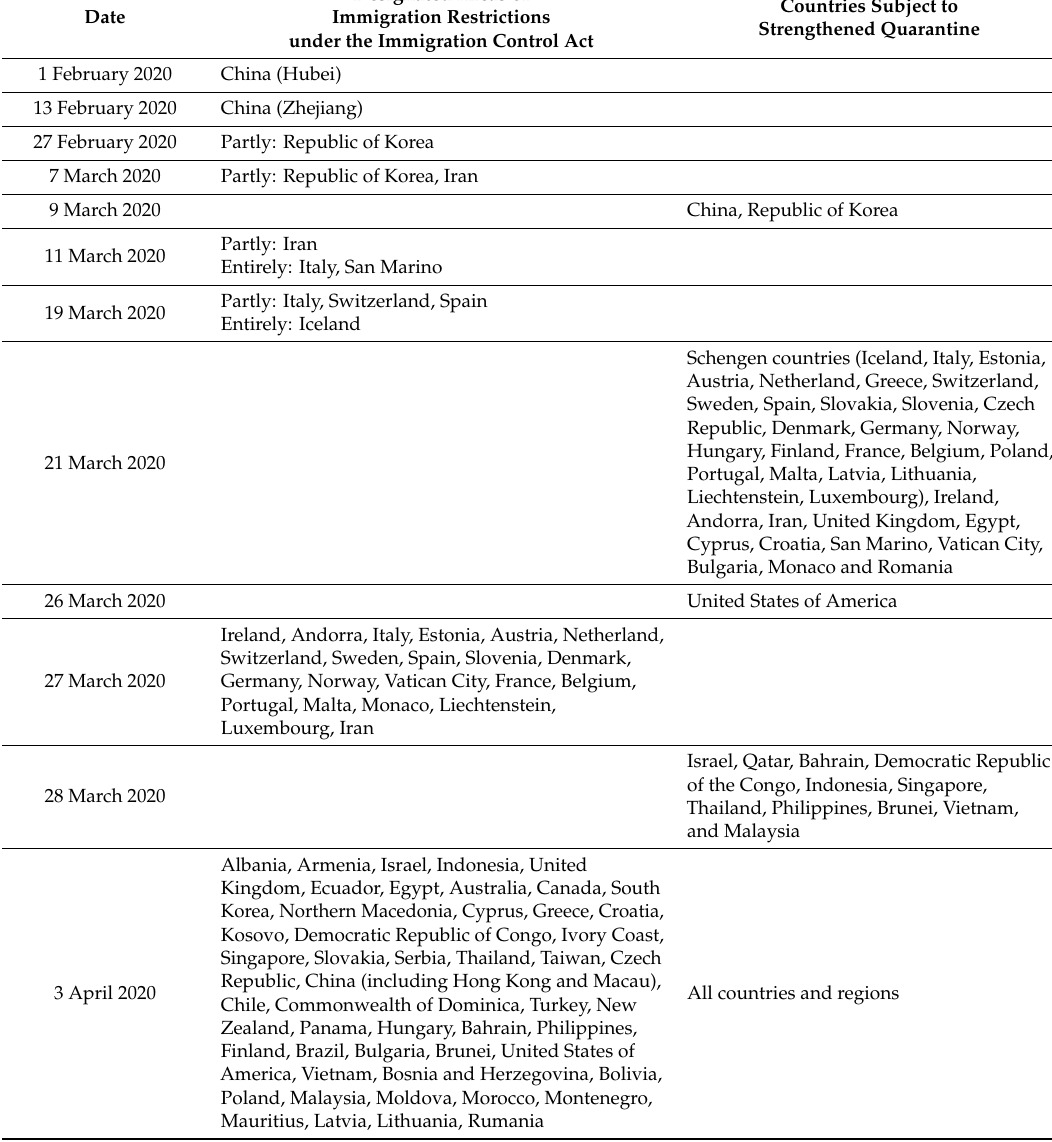
Table 2. Border control in Japan before the state of emergency on 7 April 2020